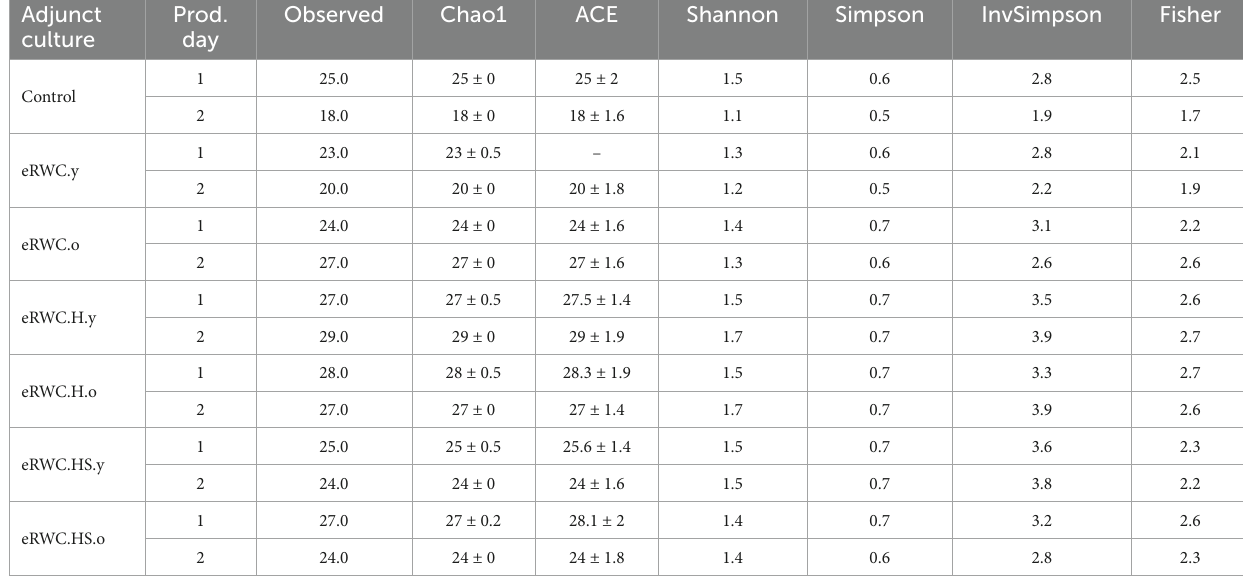
TABLE 4 Alpha diversity parameters of 120 d ripened cheese produced with different adjunct cultures. Adjunct